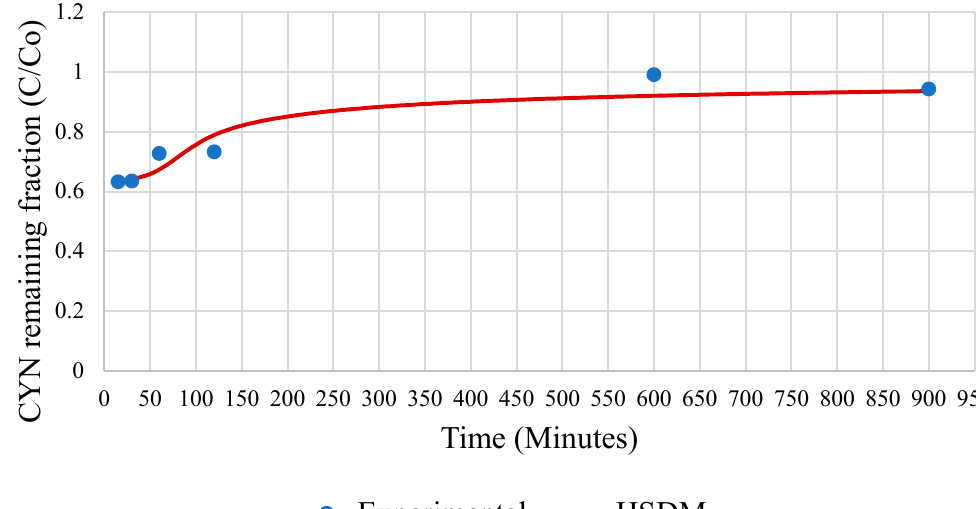
Figure 10. Average CYN remaining fraction (C/C 0 ) in the effluent from the SBA column and values predicted by the HSDM model. Input parameters used in the model: Mass of GAC = 1.1296 g; Apparent bed density = 0.476 g/cm 3 ; Grain density = 0.850 g/cm 3 ; Average particle diameter = 0.855 mm; Initial CYN concentration = 95.5 μ g/L; axial velocity = 200 m 3 /(m 2 .day); Equilibrium coefficients (Langmuir isotherm) q max = 3670 µ g/g, K L = 0.2791 L/ µ g; Mass transfer coefficients D s = 3 × 10 − 16 m 2 /s and K f = 9 × 10 − 6 m/s.